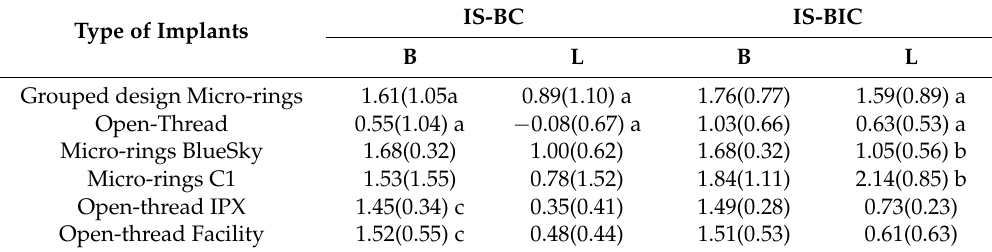
Table 1. Histomorphometric evaluation of hard tissue remodeling after eight weeks healing. Grouped data are presented for each neck design and for different types of implants with similar designs (micro-rings compared with open-thread). Results are expressed as mean ± standard